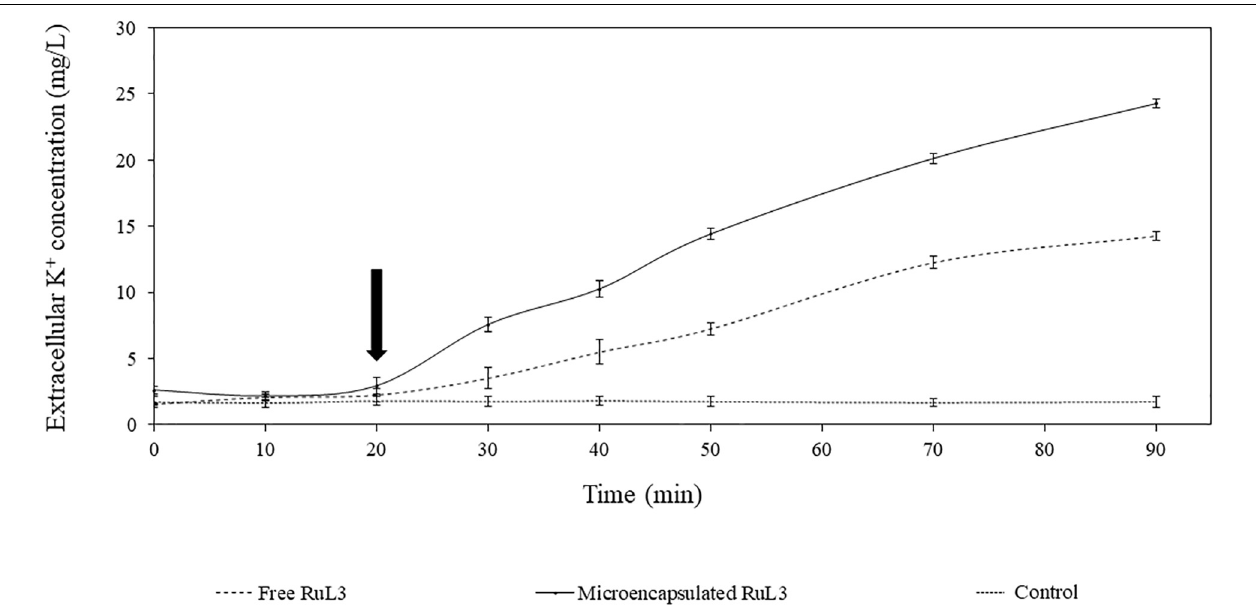
FIGURE 5 | Kinetics of intracellular potassium leakage from Escherichia coli cells after treatment with either free or microencapsulated RuL3 at the minimum inhibitory concentration. The K + concentration is presented in milligrams per liter. The treatment with TSB prepared in 50 mM MOPS buffer represents the negative control. The arrow indicates when free or microencapsulated RuL3 was added. Data are presented as means ( ± SD) of three independent repeats in triplicate.